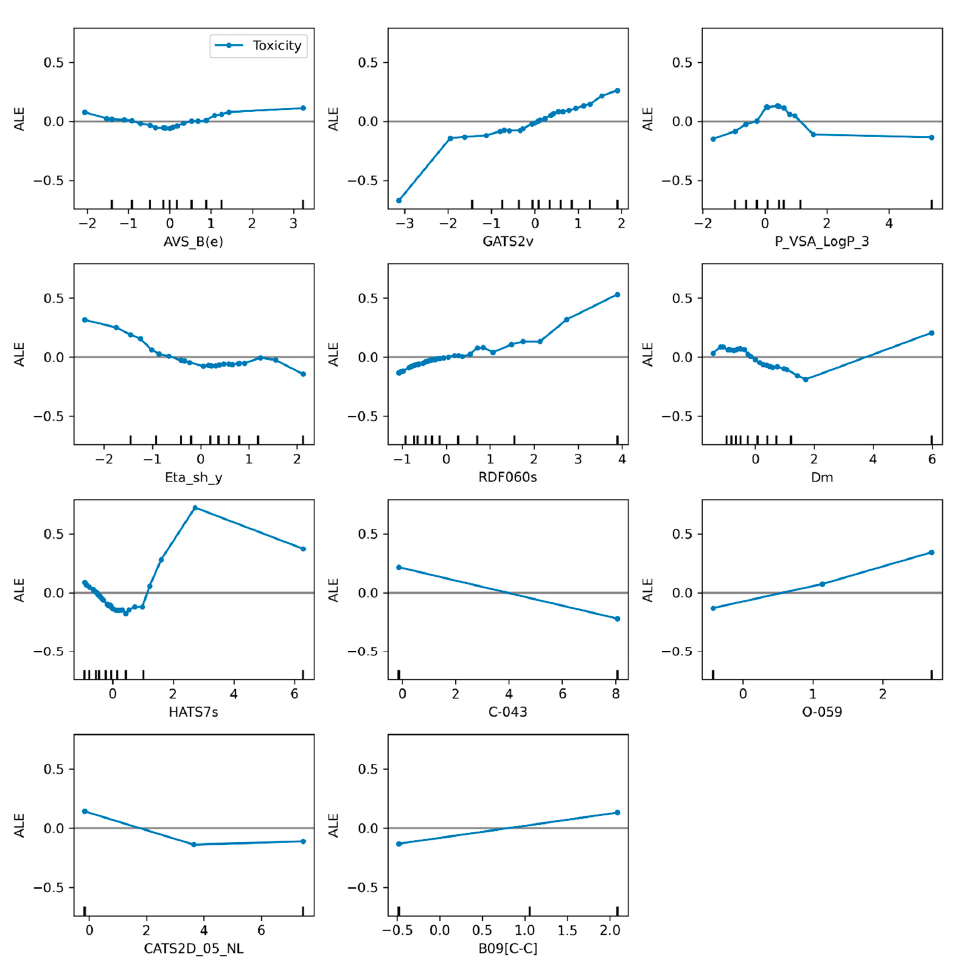
Figure 5. Descriptors weights represented by ALE plot for the SVR_A model.